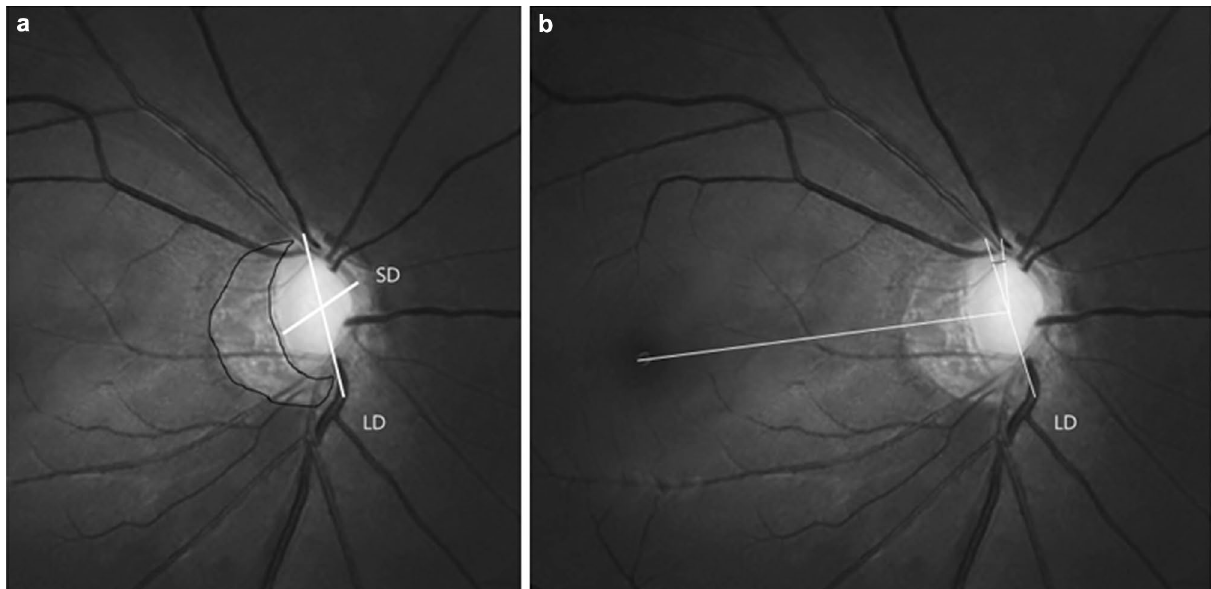
Figure 5. Identification of Tilt ratio, β-Peripapillary Atrophy area, and Torsion degree. ( a ) Tilt ratio was defined as the ratio between the longest diameter and the shortest diameter of the optic disc. The border of β-peripapillary atrophy area was drawn manually with ImageJ software, and the pixel are was calculated automatically. ( b ) Torsion degree was defined as the angle between the longest diameter and the vertical meridian of the optic disc, which meant a vertical line 90 degrees from the reference line connecting the fovea to the center of the optic disc. LD longest diameter, SD shortest